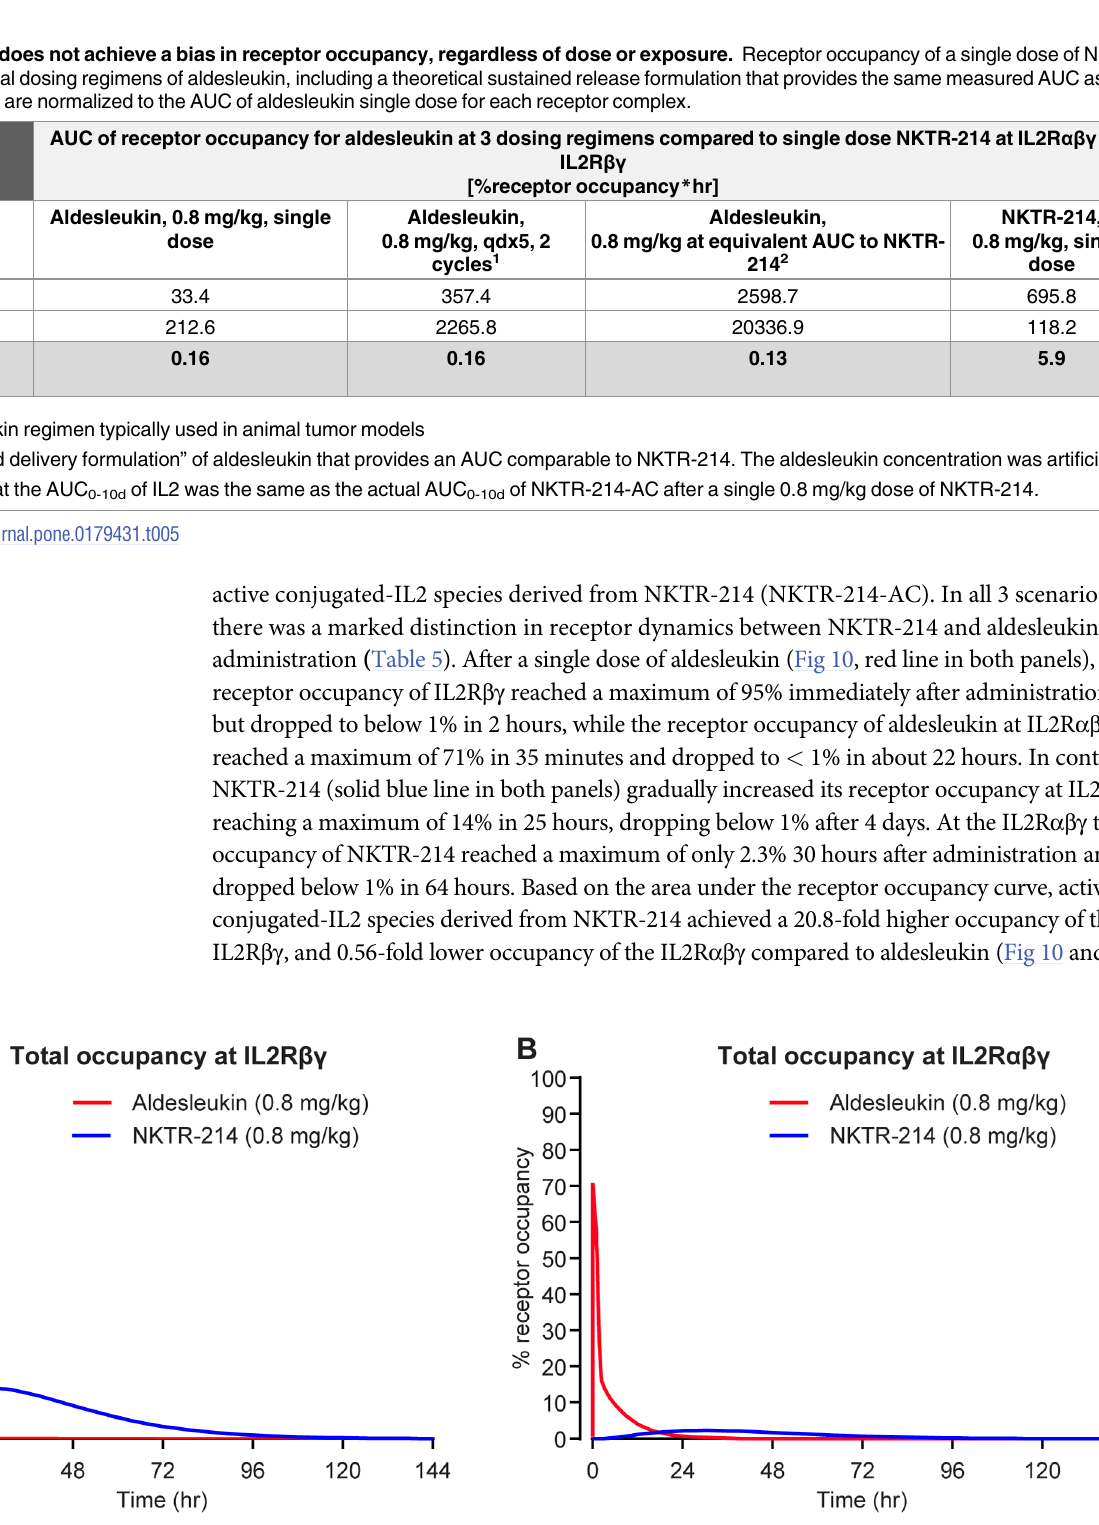
Fig 10. Receptorbias is an intrinsic property of NKTR-214. Simulationof the receptoroccupancypercentage over time for therapeuticlevels (0.8 mg/kg) of aldesleukin qdx5 (red) or NKTR-214, qd (blue) comparedhead to head. A. The receptor occupancyarea under the curve for IL2R βγ is 20.8-fold higher after NKTR-214 comparedto aldesleukin.B. In contrast, the AUC of IL2R αβγ is 0.56-fold after NKTR-214 compared to